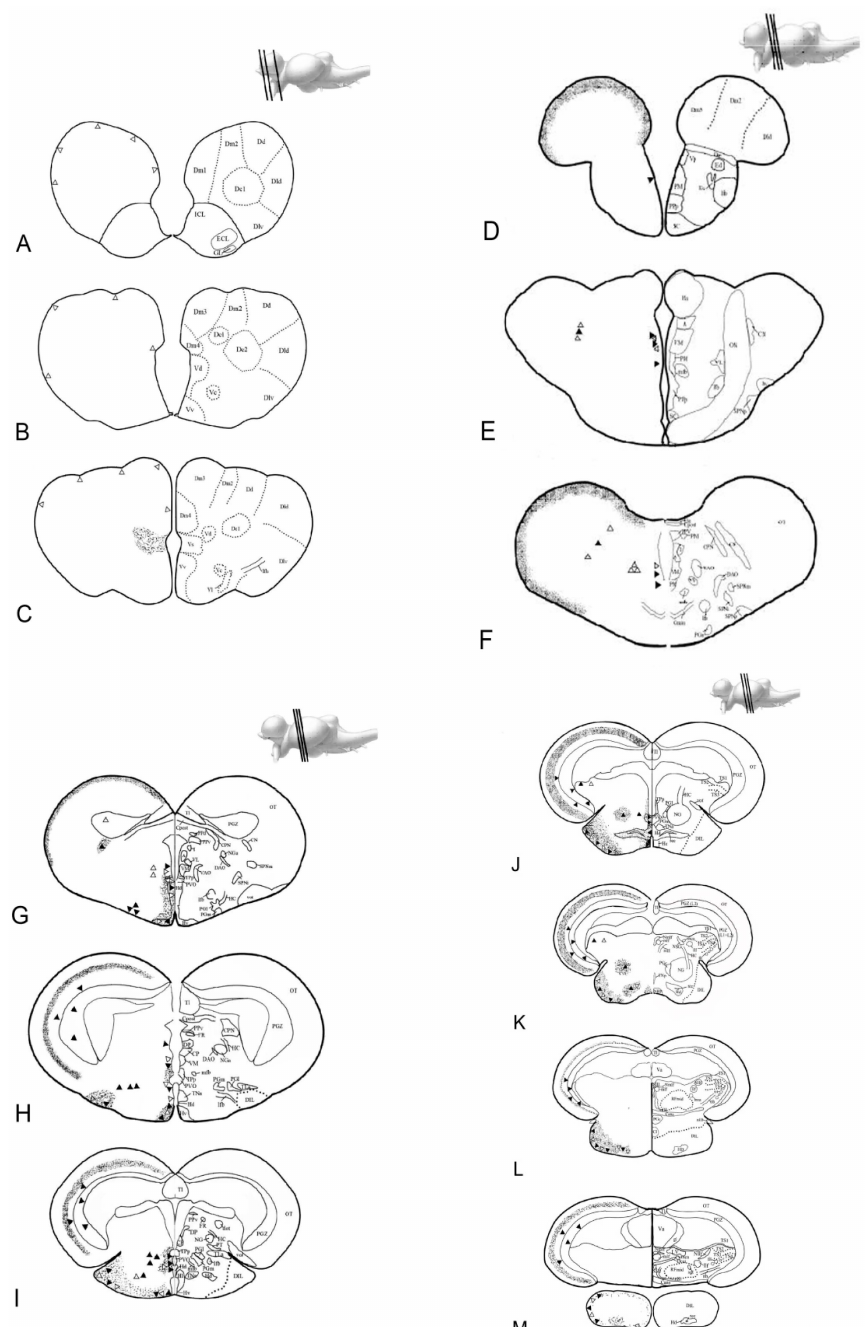
Figure 3. Atlas of NUCB2B gene and Nesf-1 protein distribution: schematic drawings of transversal sections of N. furzeri brain [46], specifically referred to ( A – F ) forebrain; ( G – M ) midbrain. White triangles indicate sites of mRNA positive neurons (ISH); black triangles indicate sites of immunopositive neurons (IHC); small dots indicate immunoreactive fibres (IHC). Scale bar: 200 µ